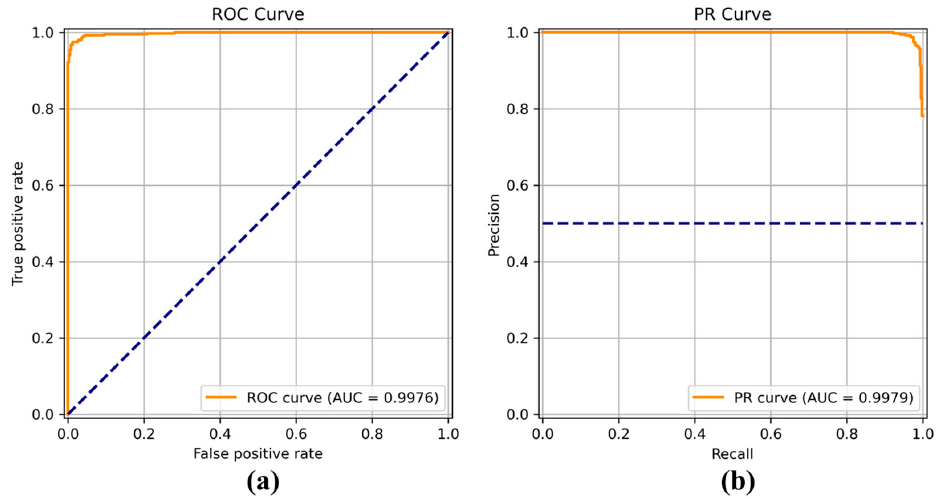
Figure 8. ( a ) Receiver operating characteristic (ROC) curve and ( b ) precision recall (PR) curve of the soft voting ensemble classifier.